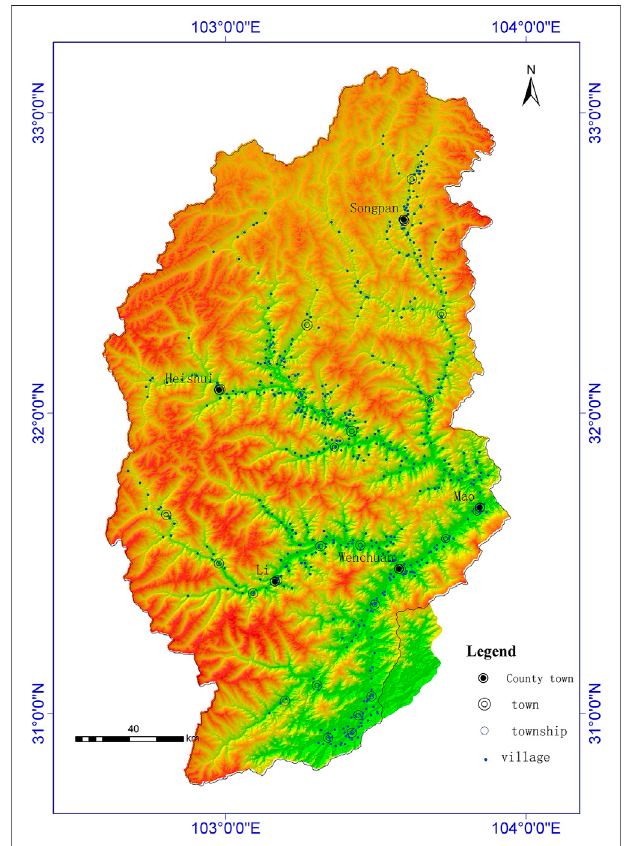
FIGURE 4 | The distribution of settlements in the upper reaches of the Min River.